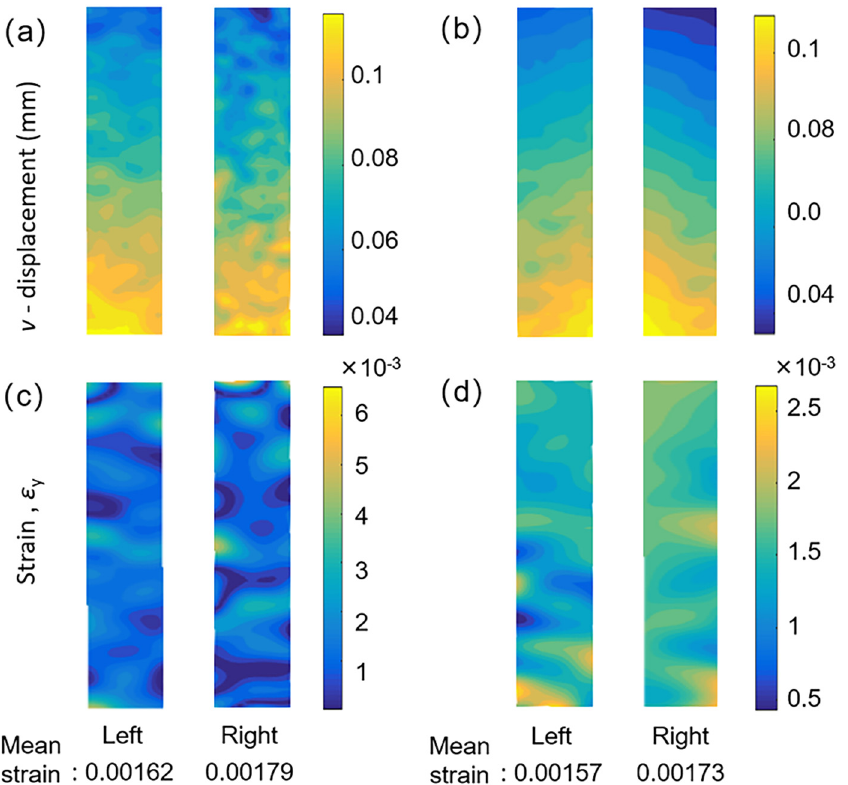
Figure 10. The longitudinal displacement ( v ) fields captured by: ( a ) the smartphone-based and ( b ) the high-resolution camera-based single-camera panoramic DIC system. ( c ) The longitudinal strain ( ε y ) fields captured by ( c ) the smartphone-based and ( d ) the high-resolution camera-based single-camera panoramic DIC system.